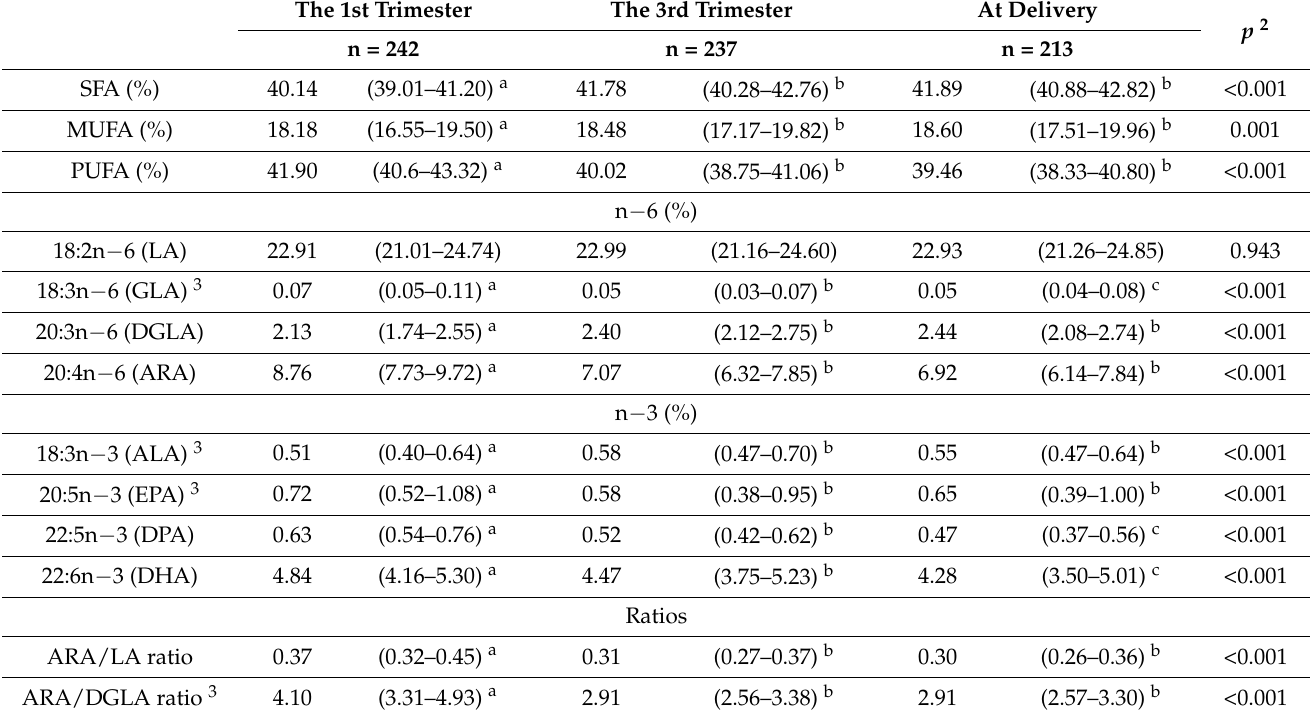
Table 2. Fatty acid compositions of maternal plasma glycerophospholipids according to gesta- tional age 1